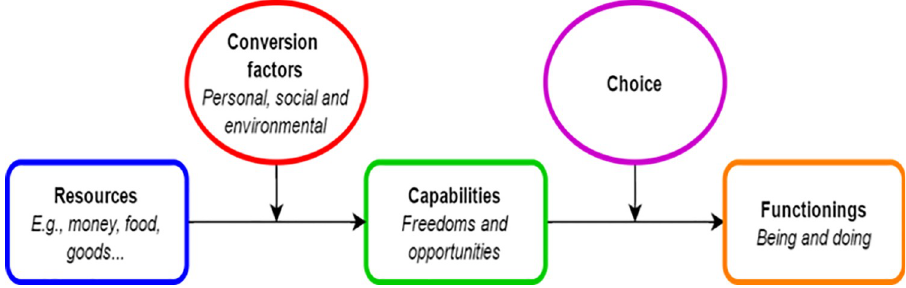
Fig 2. Schematic illustration of the theoretical framework of the capability approach. (adapted from Robeyns